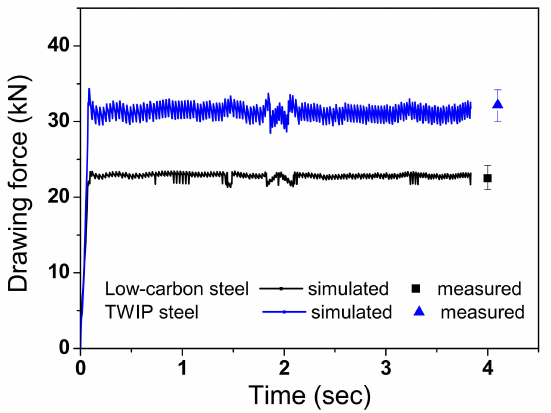
Figure 7. Comparison of the equilibrium drawing forces between experiment and FEA in low-carbon and TWIP